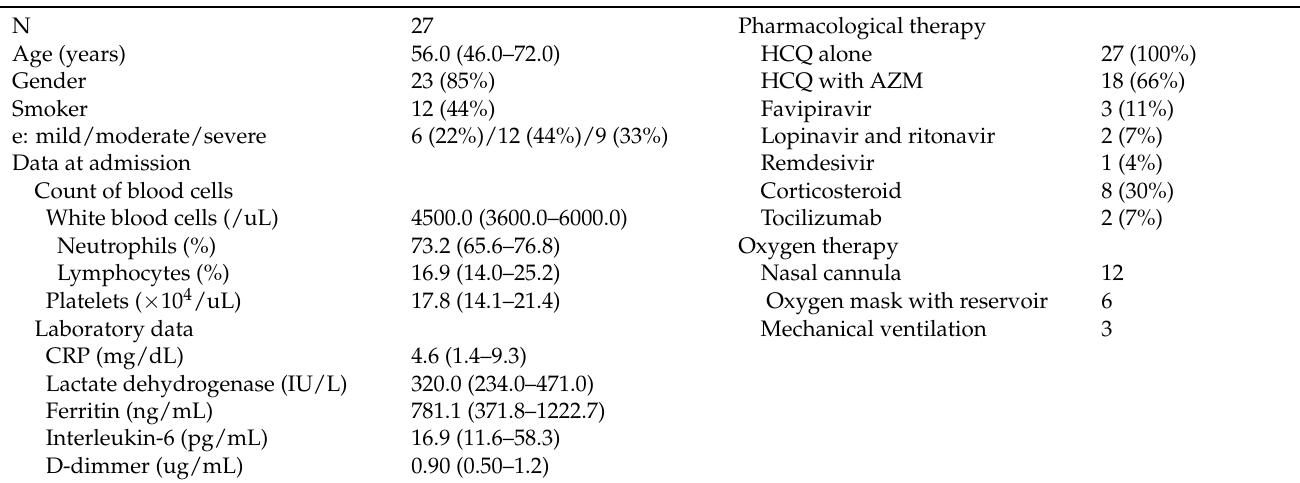
Table 1. Patient characteristics.